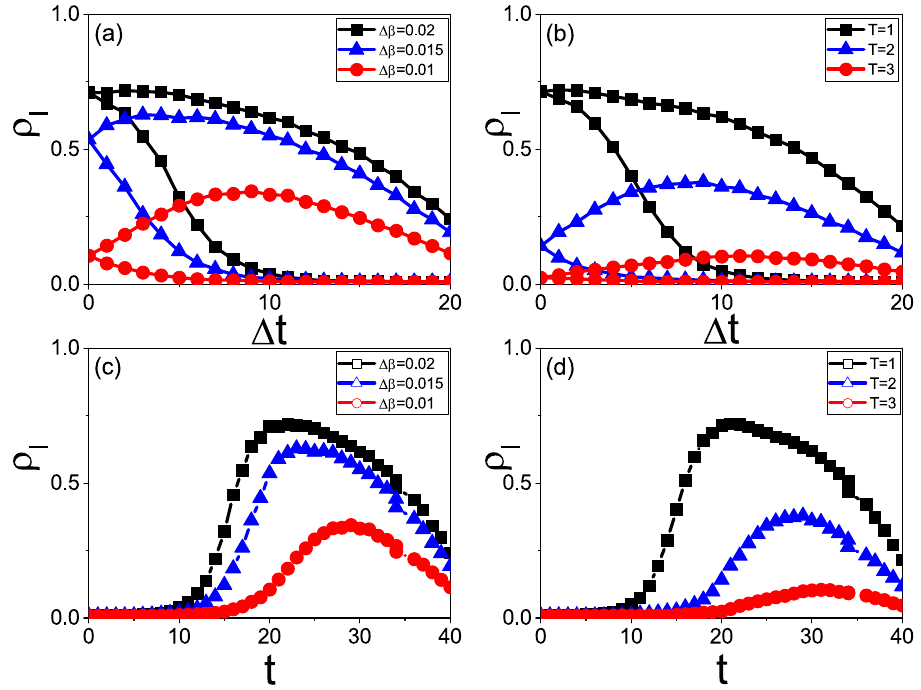
Figure 7. Case of fixed total evolutionary time as 2 × 20 (20 for the growing process and 20 for the recovering process) where all the parameters in ( a ) and ( c ) are the same as in Fig. 2(a) and that in ( b ) and ( d ) are the same as in Fig. 2(b). ( a ) and ( b ) represent the cases of S Δ t for fixed Δ β and fixed T , respectively. ( c ) and ( d ) represent the cases of S t corresponding to ( a ) and ( b ),